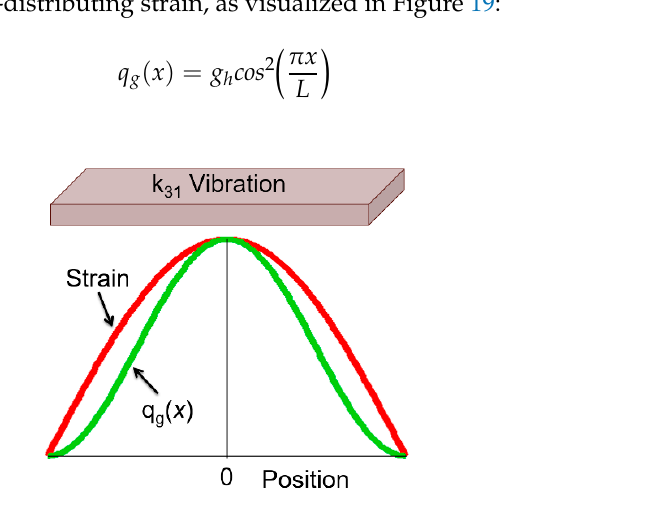
Figure 19. Heat generation modeling in proportion to strain square.